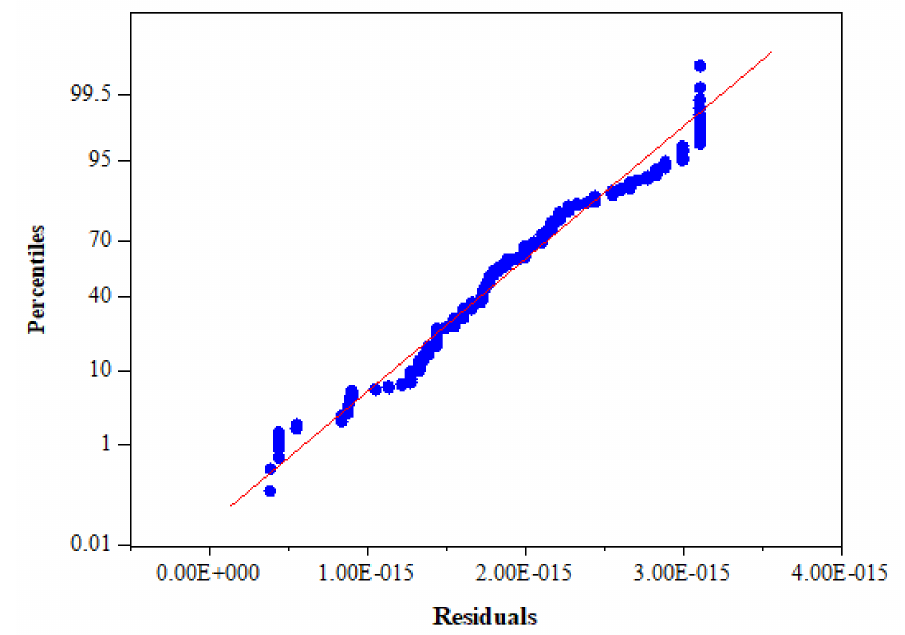
Figure 19. Normal probability plot of